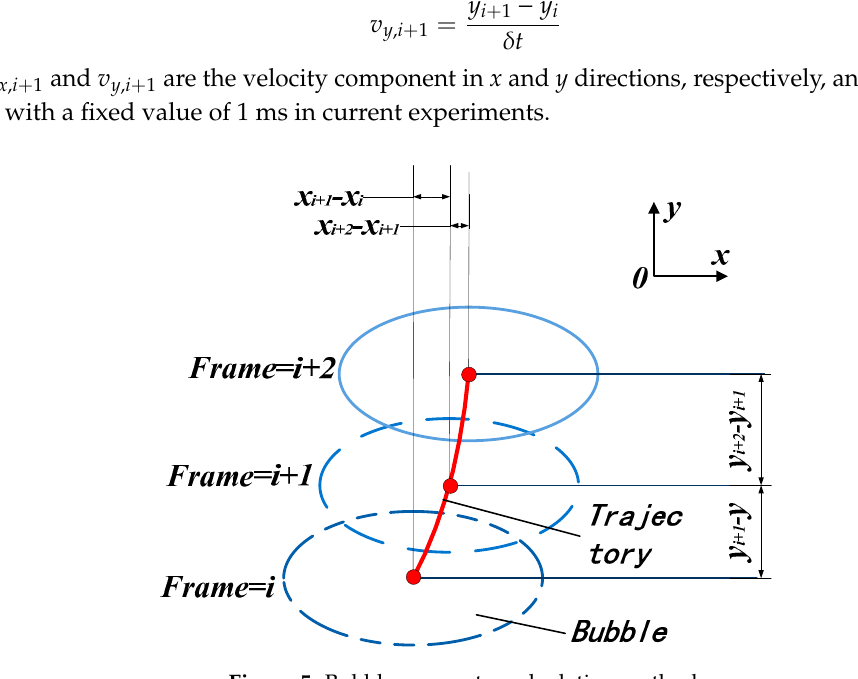
Figure 5. Bubble parameter calculation method.